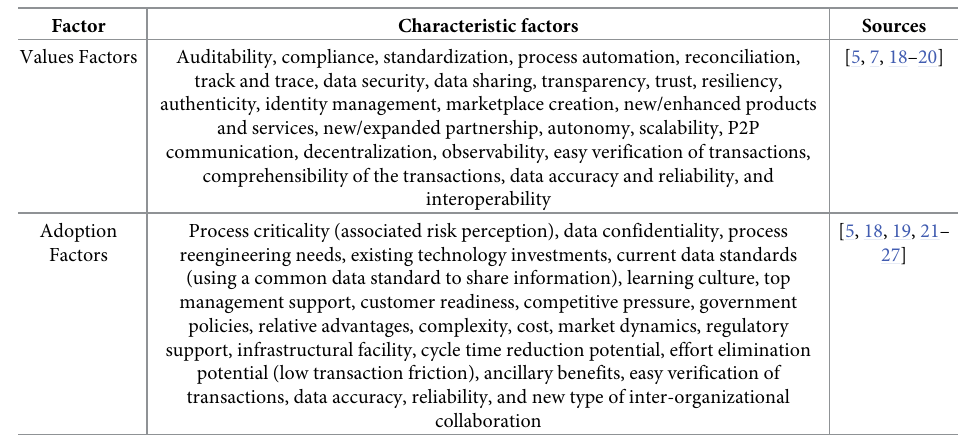
Table 1. Value and adoption factors of